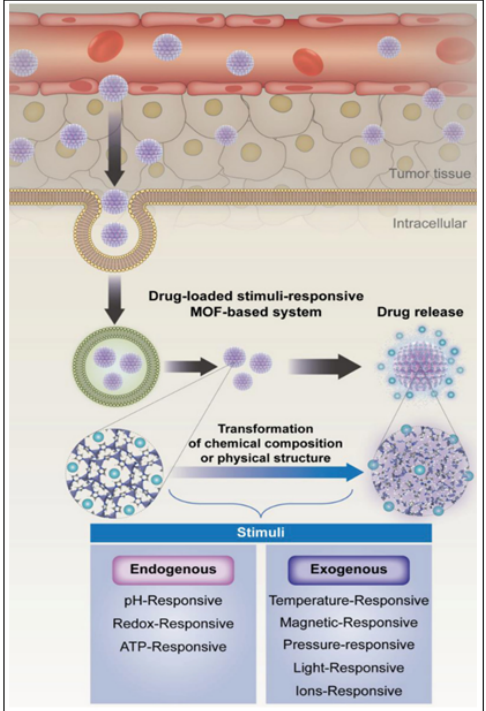
Figure 7. Various procedures of the development of stimuli-responsive BioMOF nanostructures, with examples of the types of stimuli. Reproduced with permission from Ref. [165]. Copyright © 2019, Wiley.